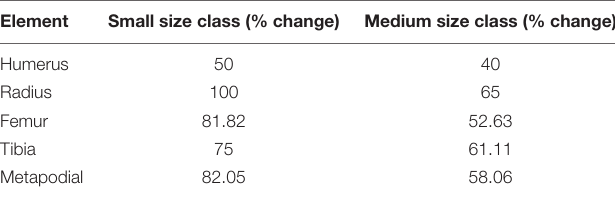
TABLE 4 | Percentage change values of long bone specimens from the small and medium size classes.